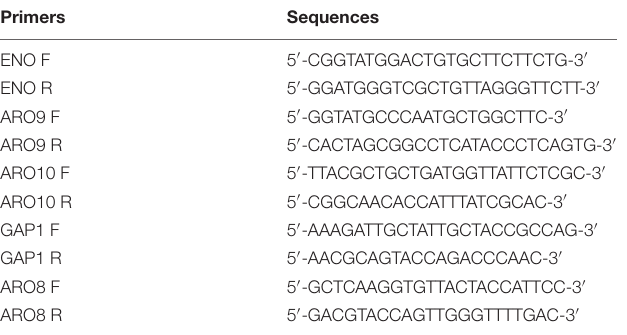
TABLE 4 | The general features of strain M2013310, Z. rouxii CBS732, and S. cerevisiae S288c